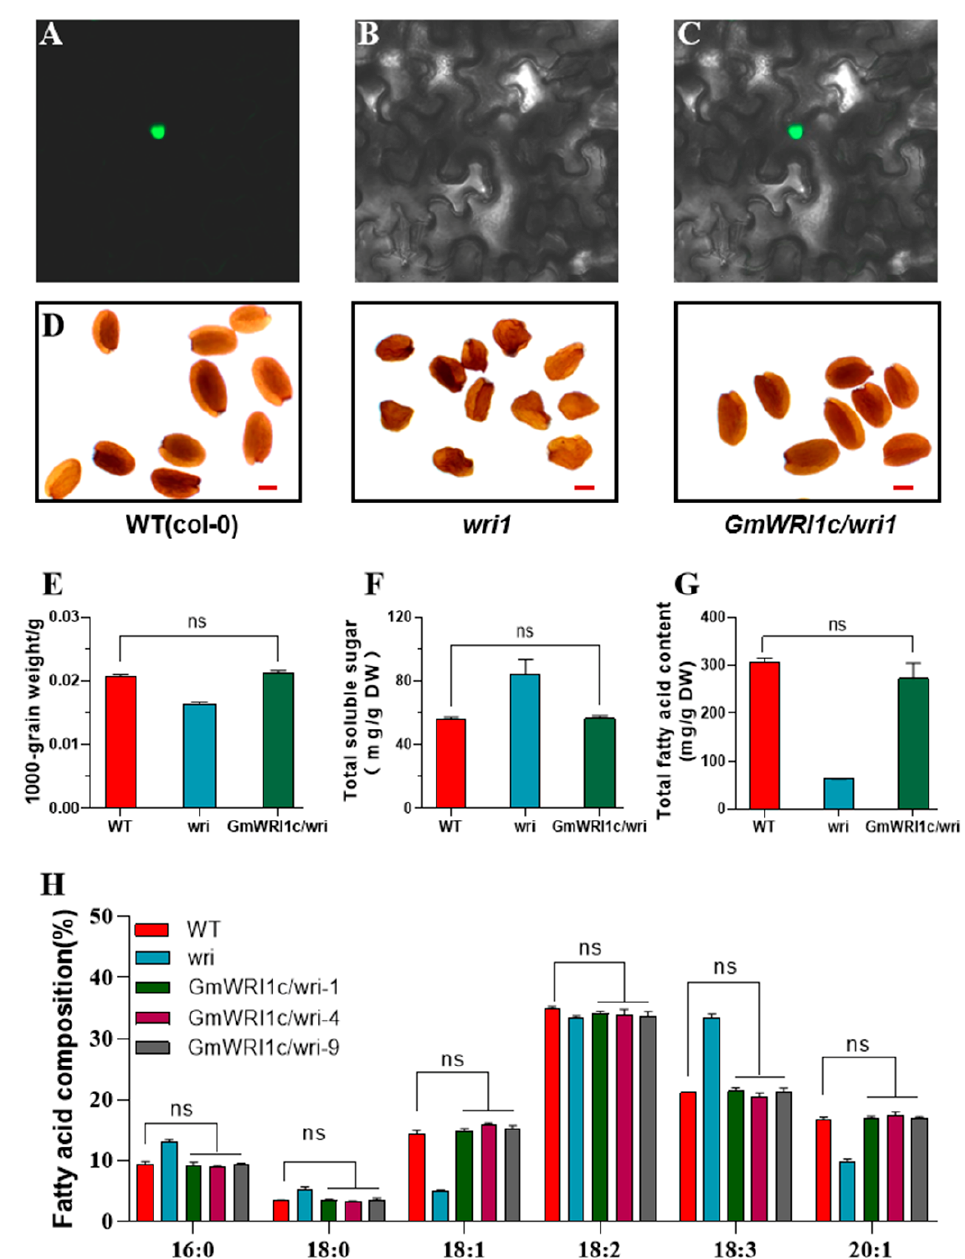
Figure 2. GmWRI1c restores the Arabidopsis wri1 mutant phenotype. ( A – C ) Subcellular localisation of GmWRI1c. Fluorescence ( A ), bright-field ( B ), and merged ( C ) images of GmWRI1c-GFP. The magnification of microscope is 20 times. ( D ) Mature seeds of the wild type (Col-0), the wri1 mutant, and wri1 complemented with 35S::GmWRI1c/wri1 . Scale bar, 0.5 mm. ( E – H ) 1000-grain weight, total soluble sugar, total fatty acid content, and fatty acid composition of mature seeds of the wild type (Col-0), the wri1 mutant, and wri1 complemented with 35S::GmWRI1c/wri1 . p -values were determined by two-tailed two-sample Welch’s t -tests.